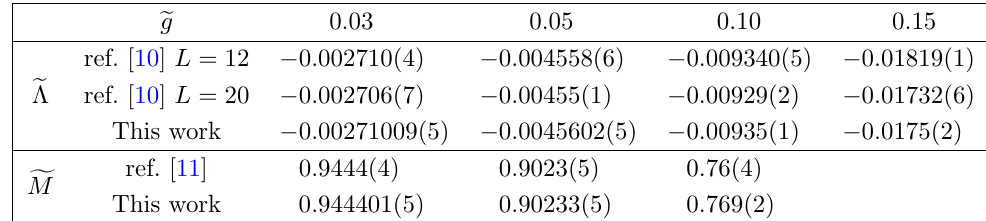
(cid:3) and M for some values of e f